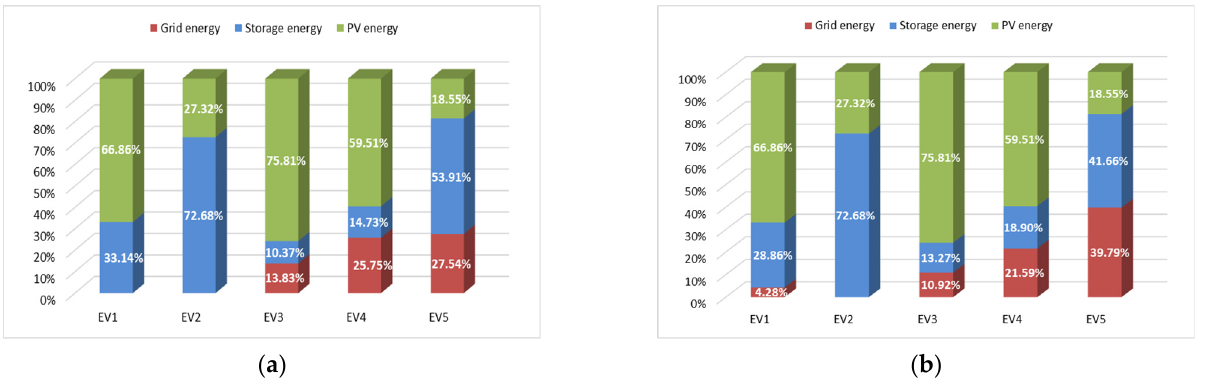
Figure 11. EV energy distribution in ( a ) “Sim w/o opt” and ( b ) “Sim with opt”—case 2.